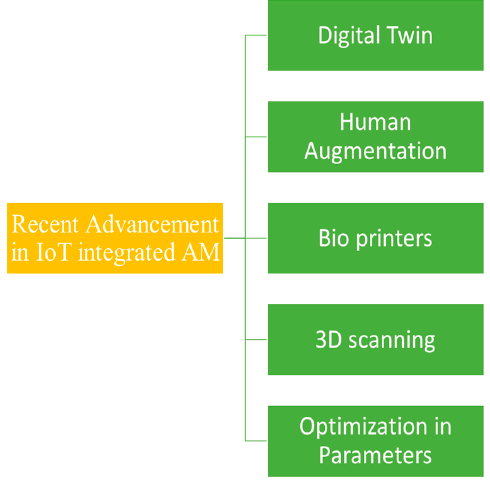
Figure 3. Recent advancements in IoT.